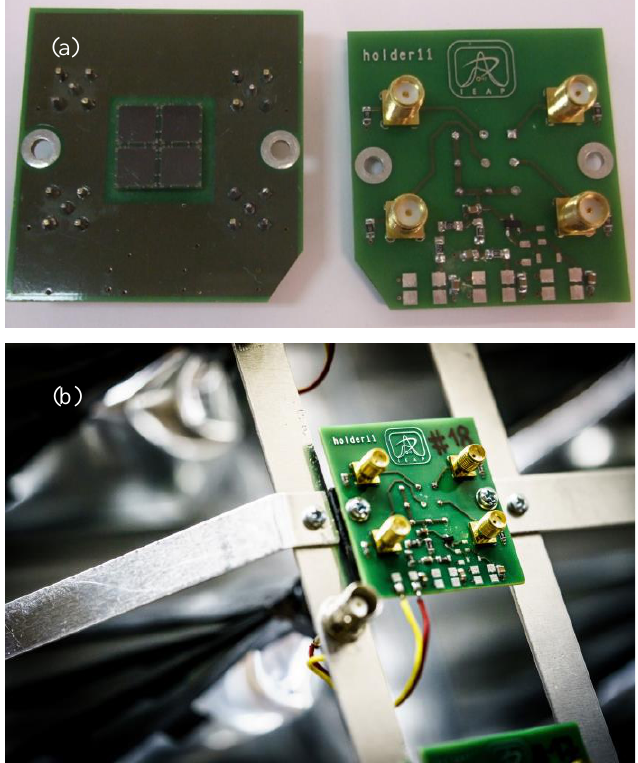
Fig. 2. The both-sided view on the PCB with four pieces of SensL SiPMs (a) and the position of the PCB with SiPMs on the S 3 detector (b). A big advantage of the front-end electronics is its negligible power consumption (maximal value of 1.7 W). This eliminates any need of cooling, even if the detector is located in a complex shielding. Electric signal from the SiPM is amplified and shaped by the signal shaping module (shaping constant is 1 μs), which is shown on the left part of Fig. 3. The signal shaping module is mechanically connected with the ADC module, see the right part of Fig. 3. The amplified and shaped signal is processed in a modular multichannel fast ADC, which consists of 84 ADC modules (15 bits + bit for a sign, 100 MS/s @ 84 channels). This multichannel system was designed and constructed at IEAP CTU in Prague and it is used for the data acquisition from the whole 80-channel S 3 detector and the 4- channel cosmic muon